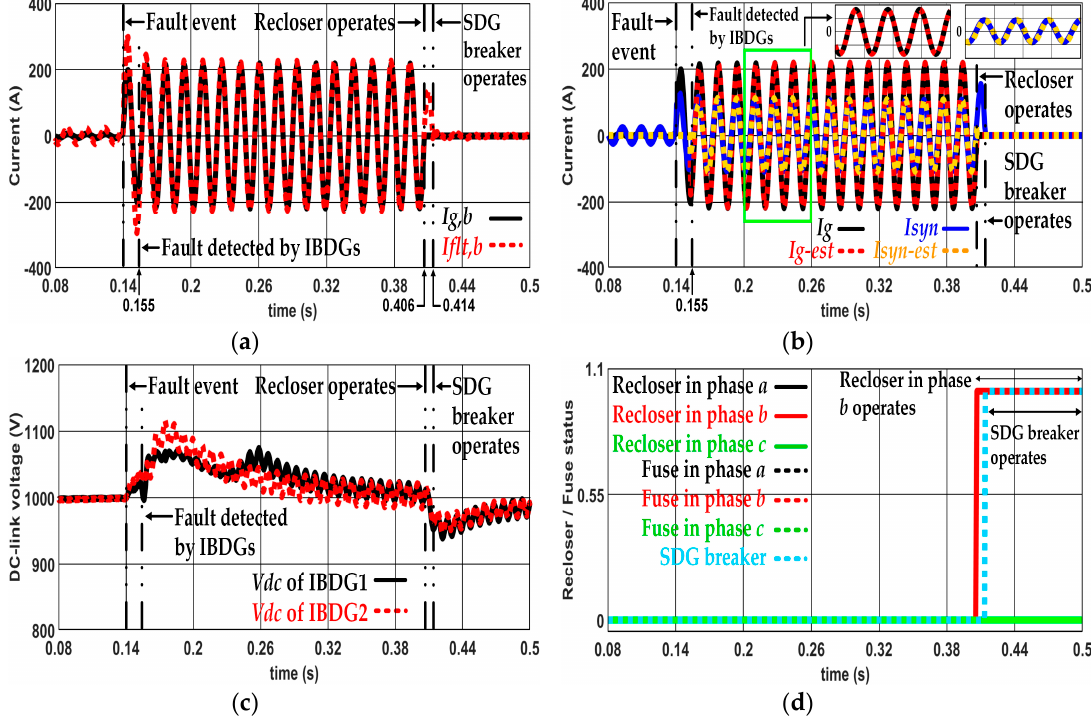
Figure 10. Separated phase–current control during temporary SLG fault: ( a ) total fault current and grid current; ( b ) real-time currents and estimated currents; ( c ) DC-link voltage; ( d ) operating time of recloser–fuse and SDG breaker.